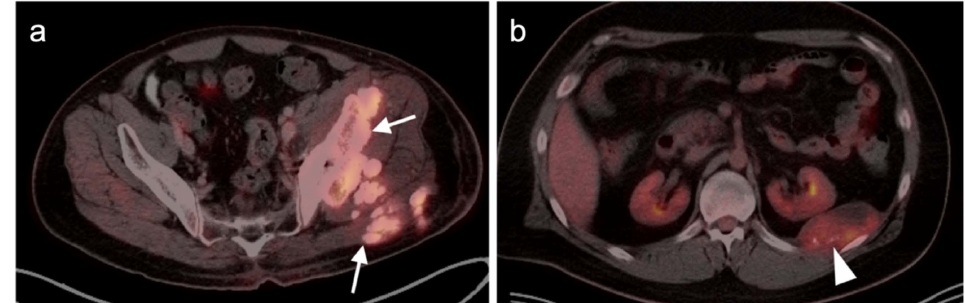
Figure 33. Osteosarcoma of the left iliac bone. ( a ) On an axial FDG PET-CT image, a bone-forming hypermetabolic tumor of the left iliac bone is associated with hypermetabolic, ossified, adjacent intramuscular metastases (white arrows). ( b ) An axial FDG PET-CT of the abdomen shows a pleural hypermetabolic metastatic lesion in the deep left posterior costophrenic sulcus with scattered internal calcifications (white arrowhead).